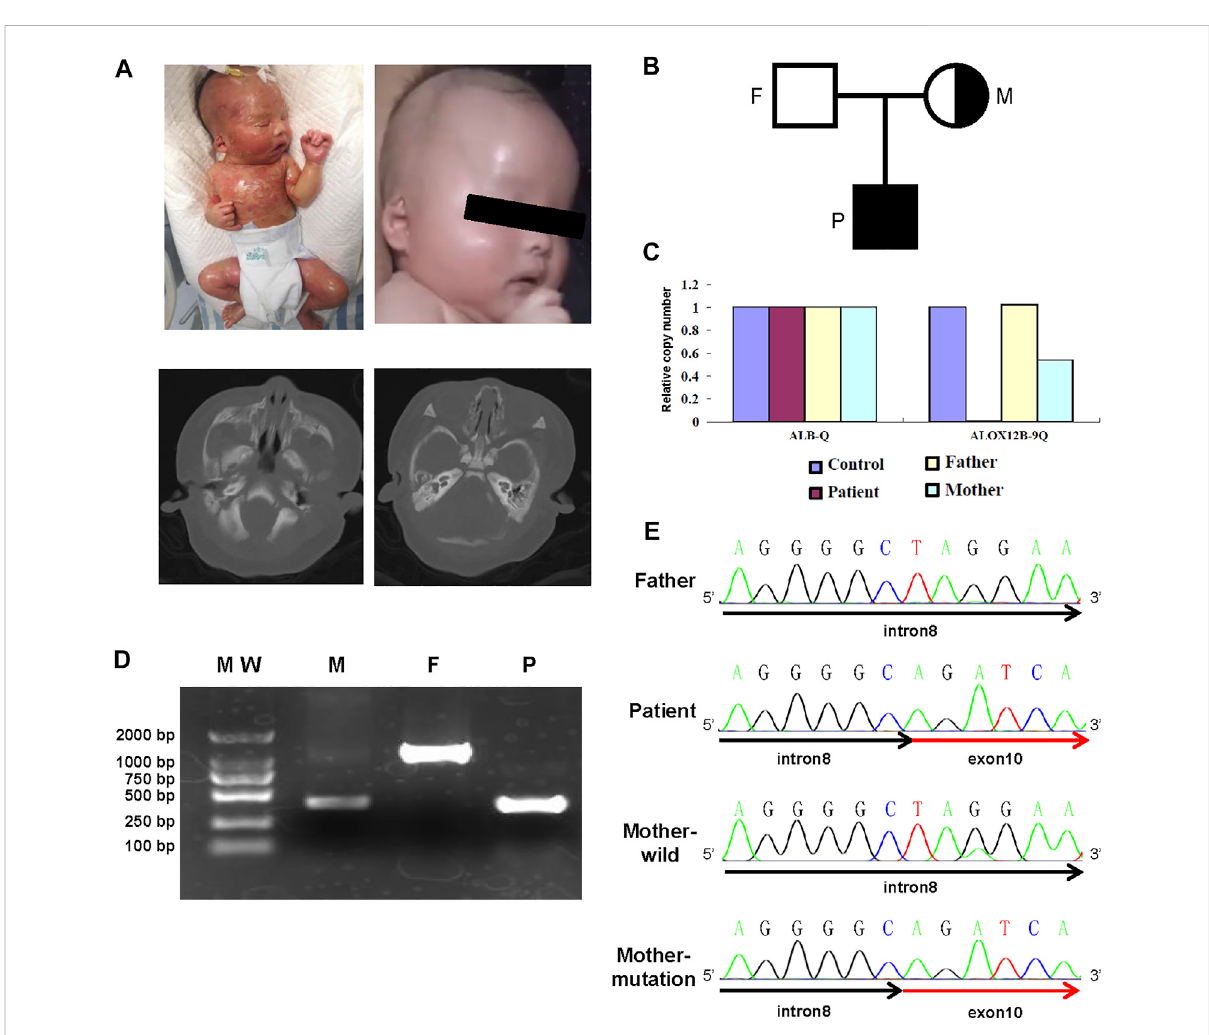
FIGURE 1 Clinical and genetic information of the family. (A) Photograph and inner ear CT of the case. Lateral view of thepatient at the age of 1 day (upper left panel) and 3 months (upper right panel). CT plain scan of the inner ear (lower panel). (B) Pedigree of the reported family. (C) Quantitative PCR histogram of ALOX12B to ALB gene. (D) Agarose gel electrophoresis of PCR ampli fi cation for samples from the patient (P), heterozygous carrier mother(M),andwild-type father(F). (E) Sangersequencingcon fi rmsthebreakpointsofthedeletionencompassingthe3 ′ endofintron8and5 ′ end of exon